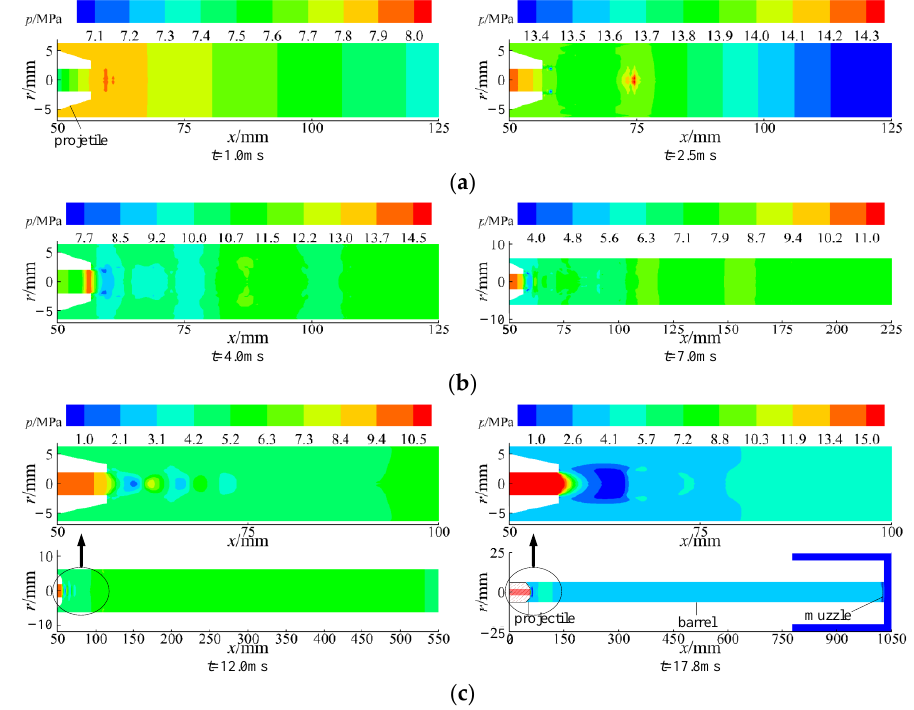
Figure 10. Pressure distribution (projectile B). ( a ) The first stage; ( b ) the second stage; ( c ) the third stage.